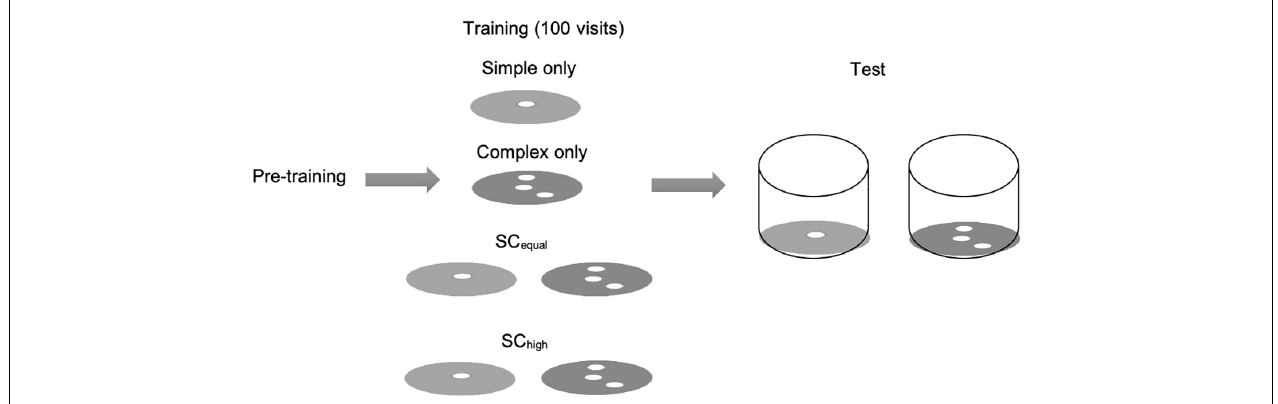
FIGURE 1 | Experimental design and scheme of the artificial flowers. Bees were allocated to one of four training types on artificial flowers with a flat landing surface. In the test phase, all foragers were exposed to a mixture of simple and complex flowers, which could only be accessed by passing through a short tunnel. Floral choices, feeding success and handling times during the test phase were